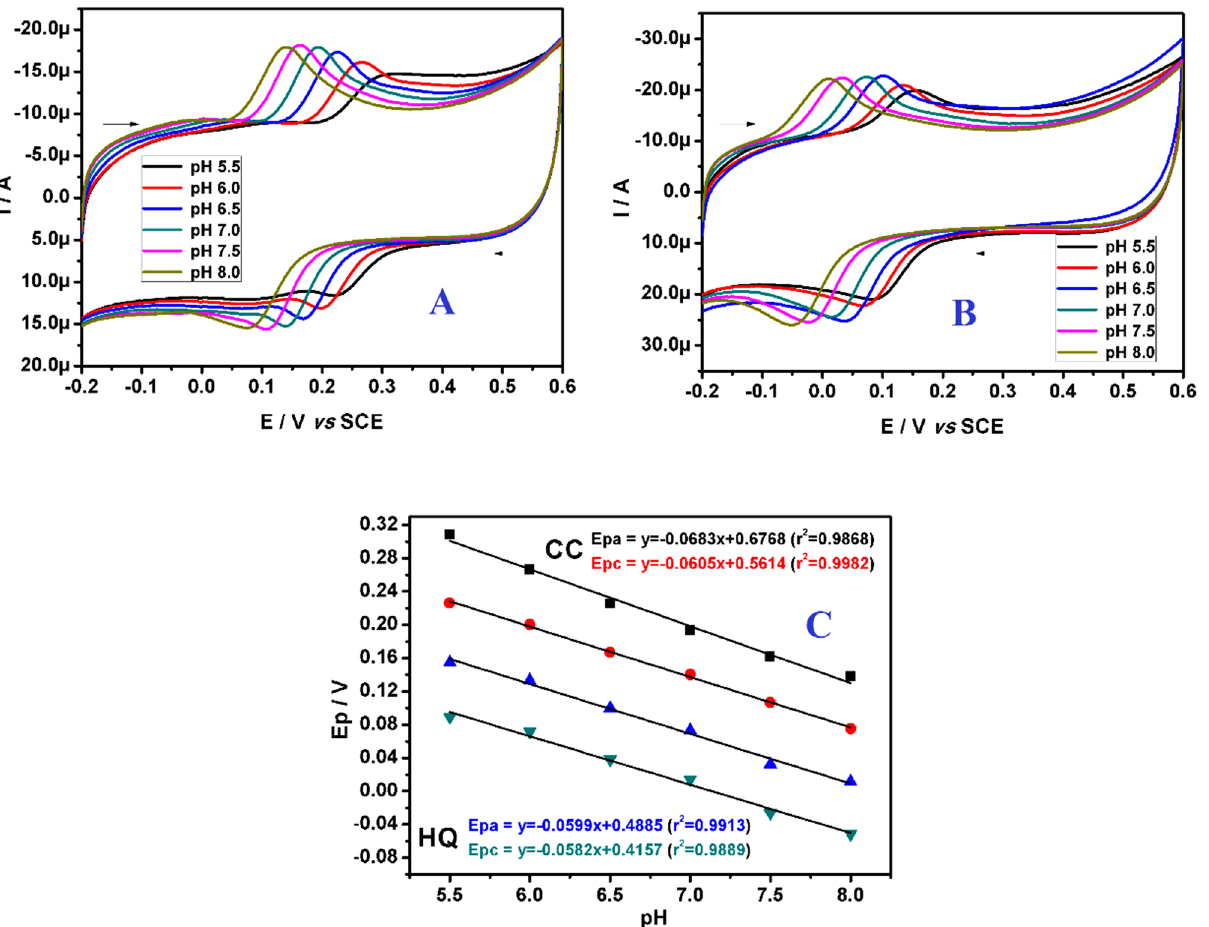
Figure 8. ( A ) CVs obtained for electrooxidation of 20.0 μM CC at polysorbate/CPE in buffer of different pH (5.5 to 8.0) at 0.05 Vs −1 scan rate. ( B ) CVs obtained for electrooxidation of 20.0 μM HQ at polysorbate/CPE in buffer of different pH (5.5 to 8.0) at 0.05 Vs −1 scan rate. ( C ) Graph of peak potentials of CC and HQ versus pH of buffer